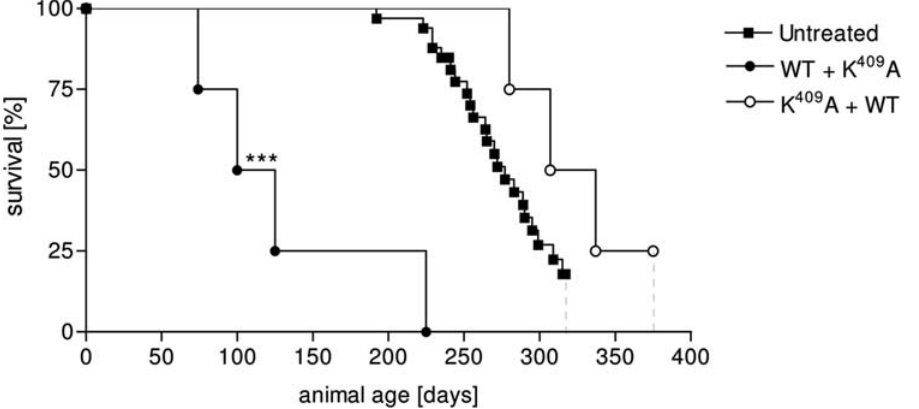
Figure 6. Combined effect of WT and K 409 A Hsp65 in survival time. Forty-five days-old female [NZBxNZW]F 1 mice were treated with WT or K 409 A and after 7 days, received K 409 A or WT rHsp65. Untreated group has been the reference group for log-rank analysis; *** p , 0.001. Results are representative of 2 independent experiments.